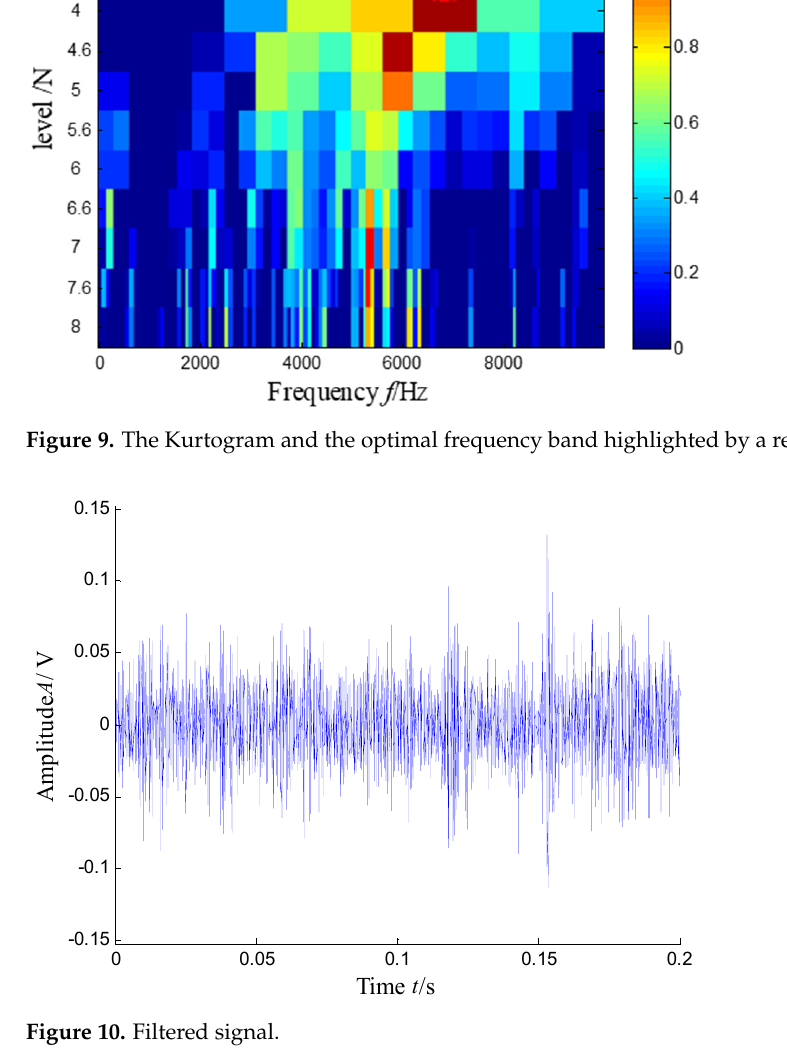
Figure 10. Filtered signal. Figure 10. Filtered